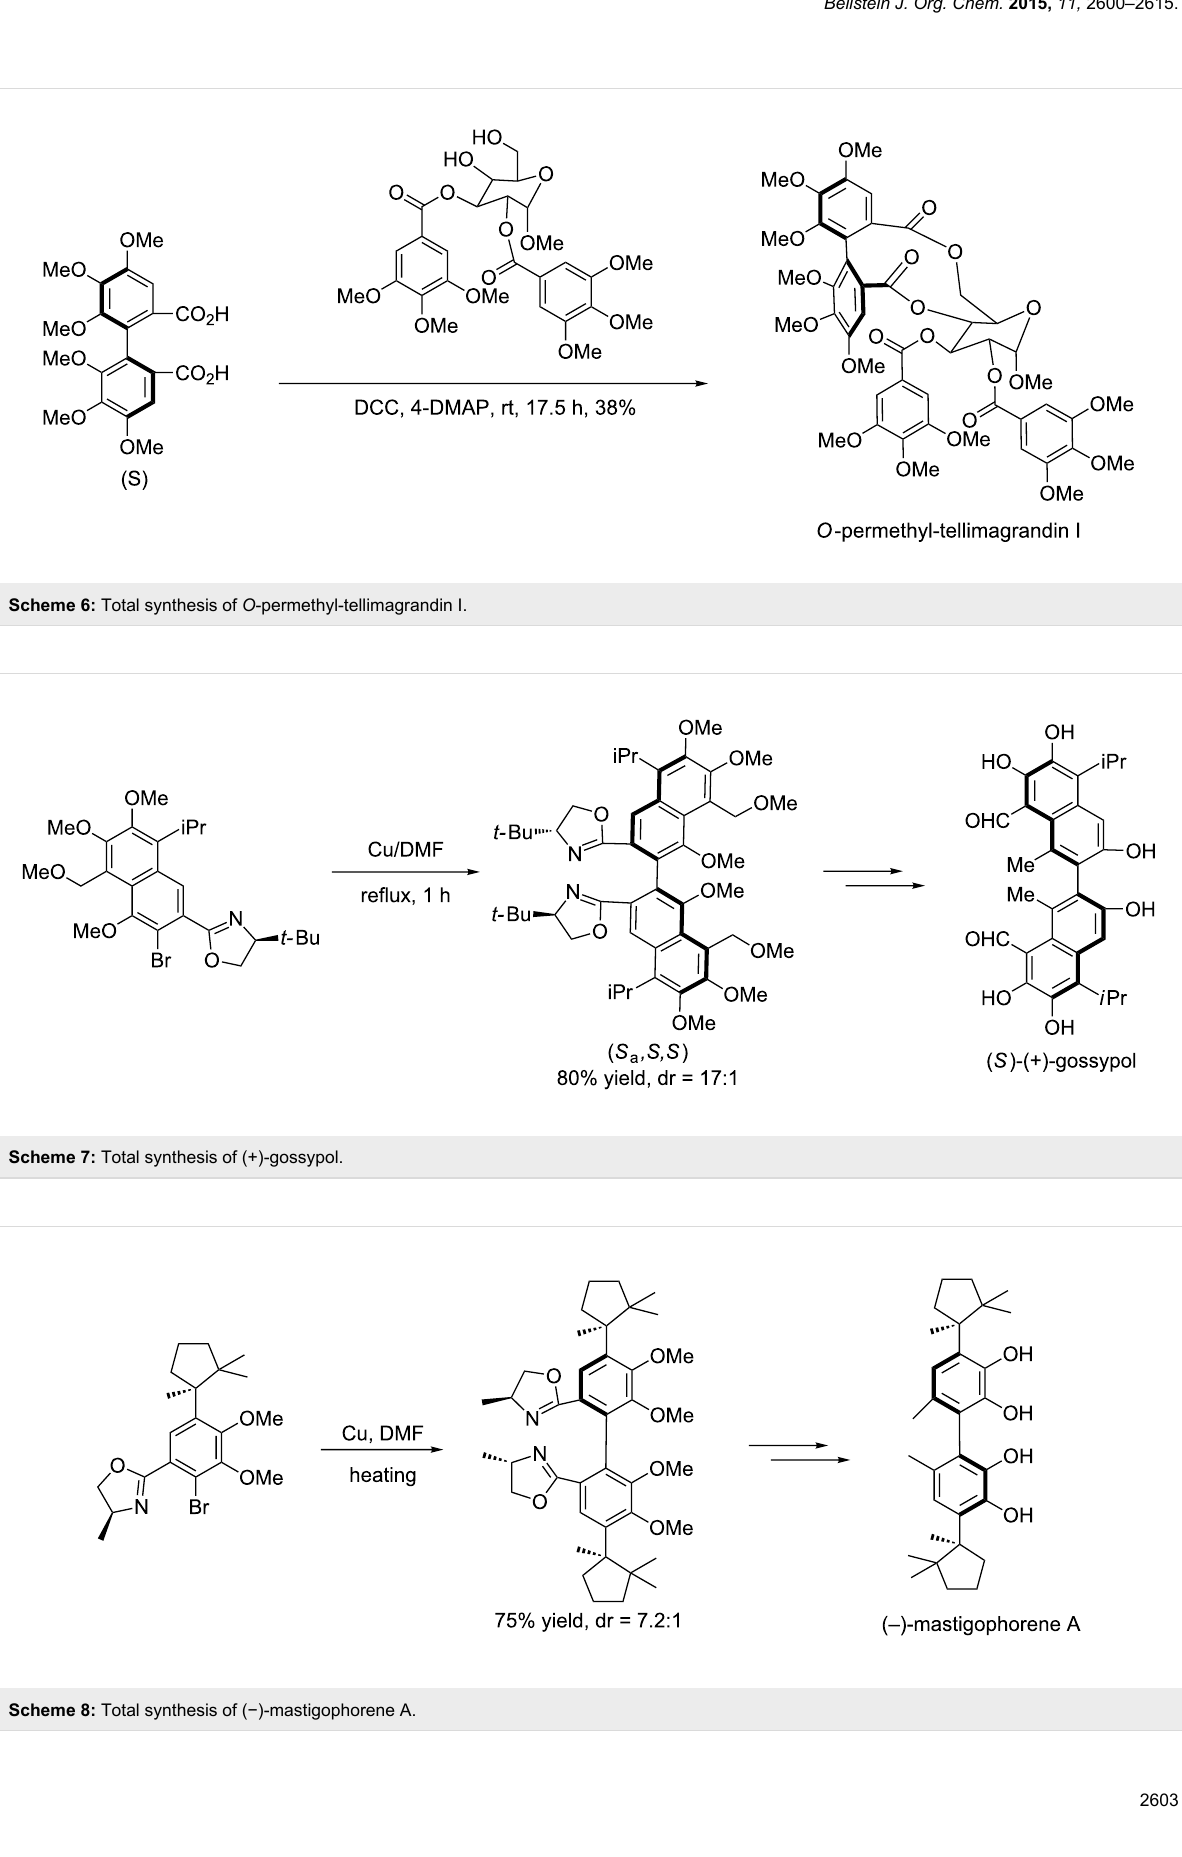
Scheme 8: Total synthesis of ( − )-mastigophorene